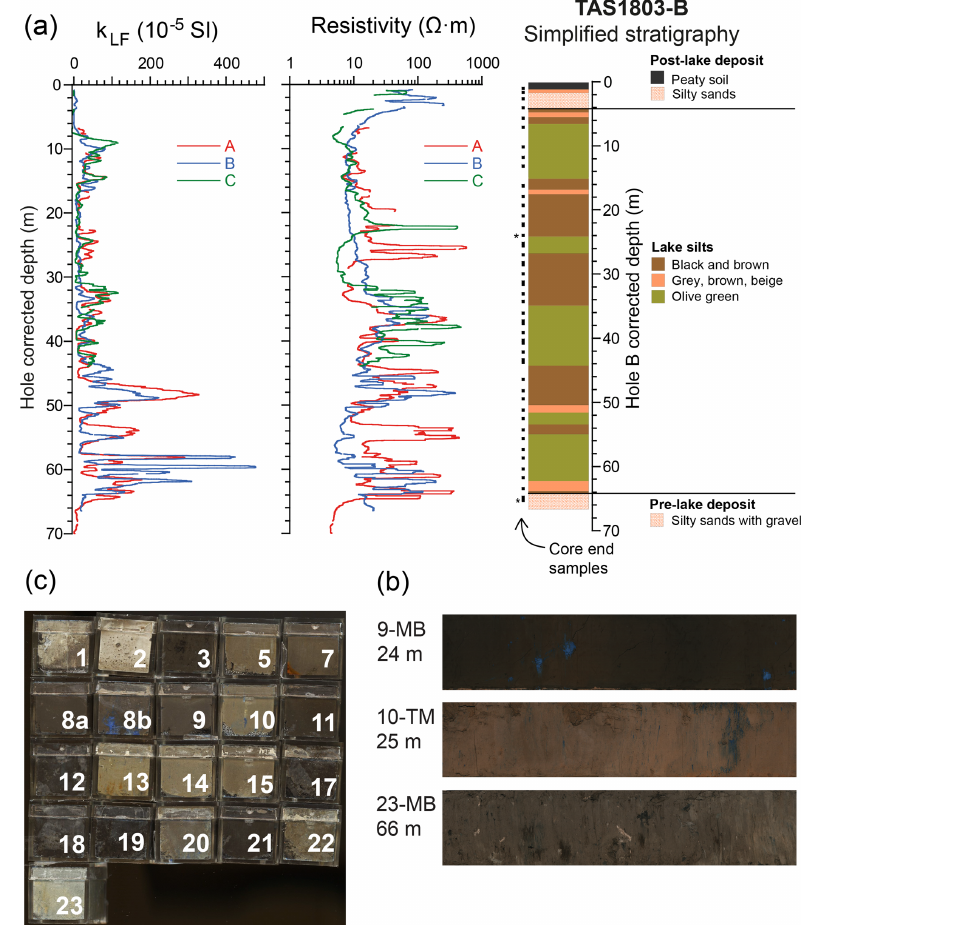
Figure 4. (a) Superimposed plots of volumetric magnetic susceptibility ( k LF ) and resistivity data from Holes A, B, and C (smoothed over 50 data points), and simplified stratigraphy of site TAS1803 Hole B, which was split in half lengthwise, visually described, and photographed. The position of the core end samples and the paleomagnetic samples in Fig. 6 are indicated with square and asterisk (*), respectively. (b) Core end cube samples from Hole B, and (c) representative lithologies for black-brown silt (section 9-MB), olive-green silt (section 10-TM) and pre-lake deposits (section 23-MB). The blue mineral visible in sections 9-MB and 10-TM, and cubes 8b and 10 is tentatively identified as